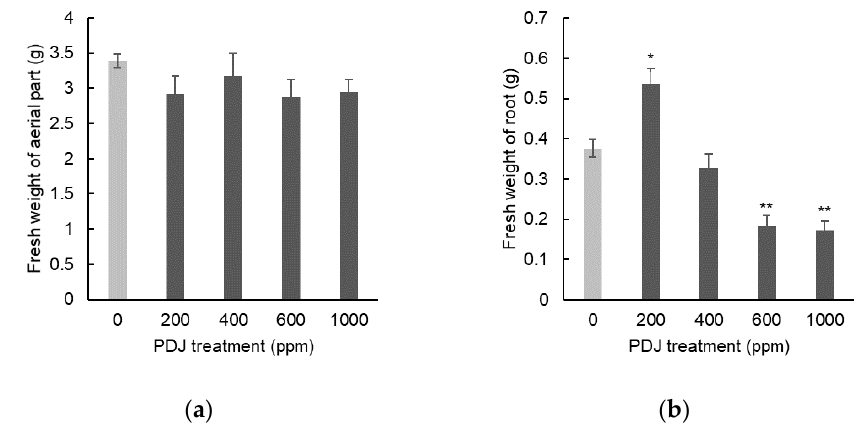
Figure 3. Shoot length ( a ), leaf width ( b ), and root length ( c ) of komatsuna seedlings sprayed with PDJ at various concentrations. Komatsuna seeds were germinated and grown in soil, and PDJ was sprayed onto seedlings at 1 week before harvest. Shoot length and leaf width values are the average difference between characteristics measured before and after treatment ( n = 4). Root length is average value ( n = 4) measured on the final day of pot culture (day 21). Error bars indicate standard error (SE). Asterisks (* and **) indicate statistically significant difference in comparison to the control using t-test at p < 0.05 and p < 0.01, respectively.